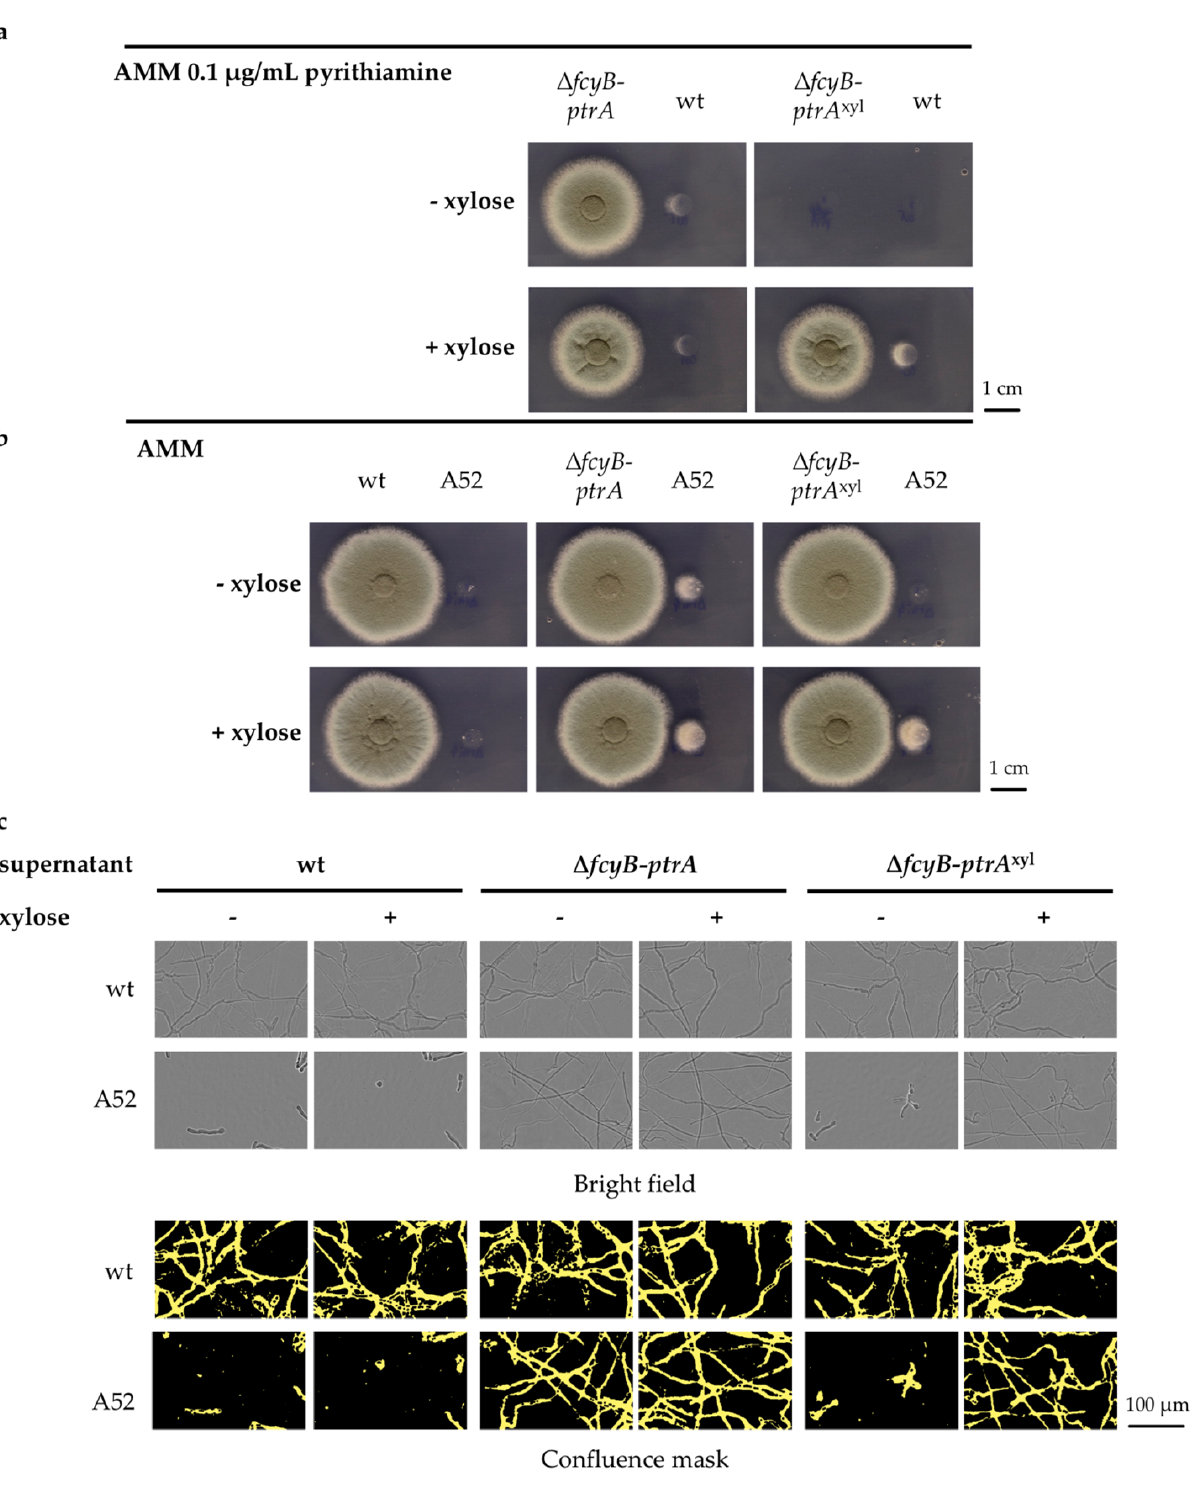
Figure 4. Effect of ptrA cassette, both inducible and non-inducible, on fungal growth. ( a ) Spot assay on solid AMM containing 0.1 µ g/mL pyrithiamine showing the proximity effect of the ptrA- carrying strain ∆ fcyB-ptrA ( left ) or ∆ fcyB- ptrA xyl ( right ) on the wt both in the absence and presence of xylose. ( b ) Spot assay on solid AMM using A52 as a reporter strain in proximity to wt, ∆ fcyB-ptrA , or ∆ fcyB-ptrA xyl in the absence and presence of xylose. ( c ) Representative images showing fungal growth of A52 growth after 20 h in liquid AMM at 37 ◦ C using A. fumigatus wt, ∆ fcyB-ptrA , and ∆ fcyB-ptrA xyl culture supernatants collected at 18 h in either the presence or absence of xylose. Phase images ( top ) are shown for better visualization together with the respective confluence mask images ( bottom